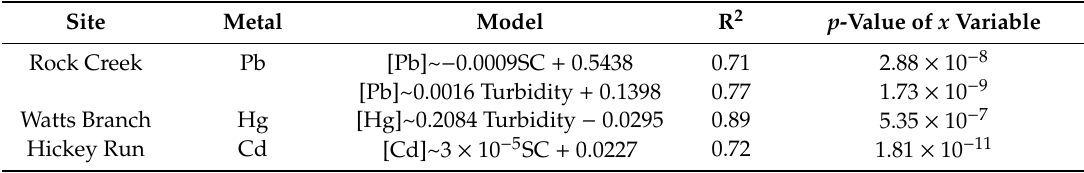
Table 4. Only relationships with a correlation coe ffi cient of 0.70 or higher are displayed. Table4. SimpleLinearRegressionmodelsfortheRockCreek, HickeyRun,